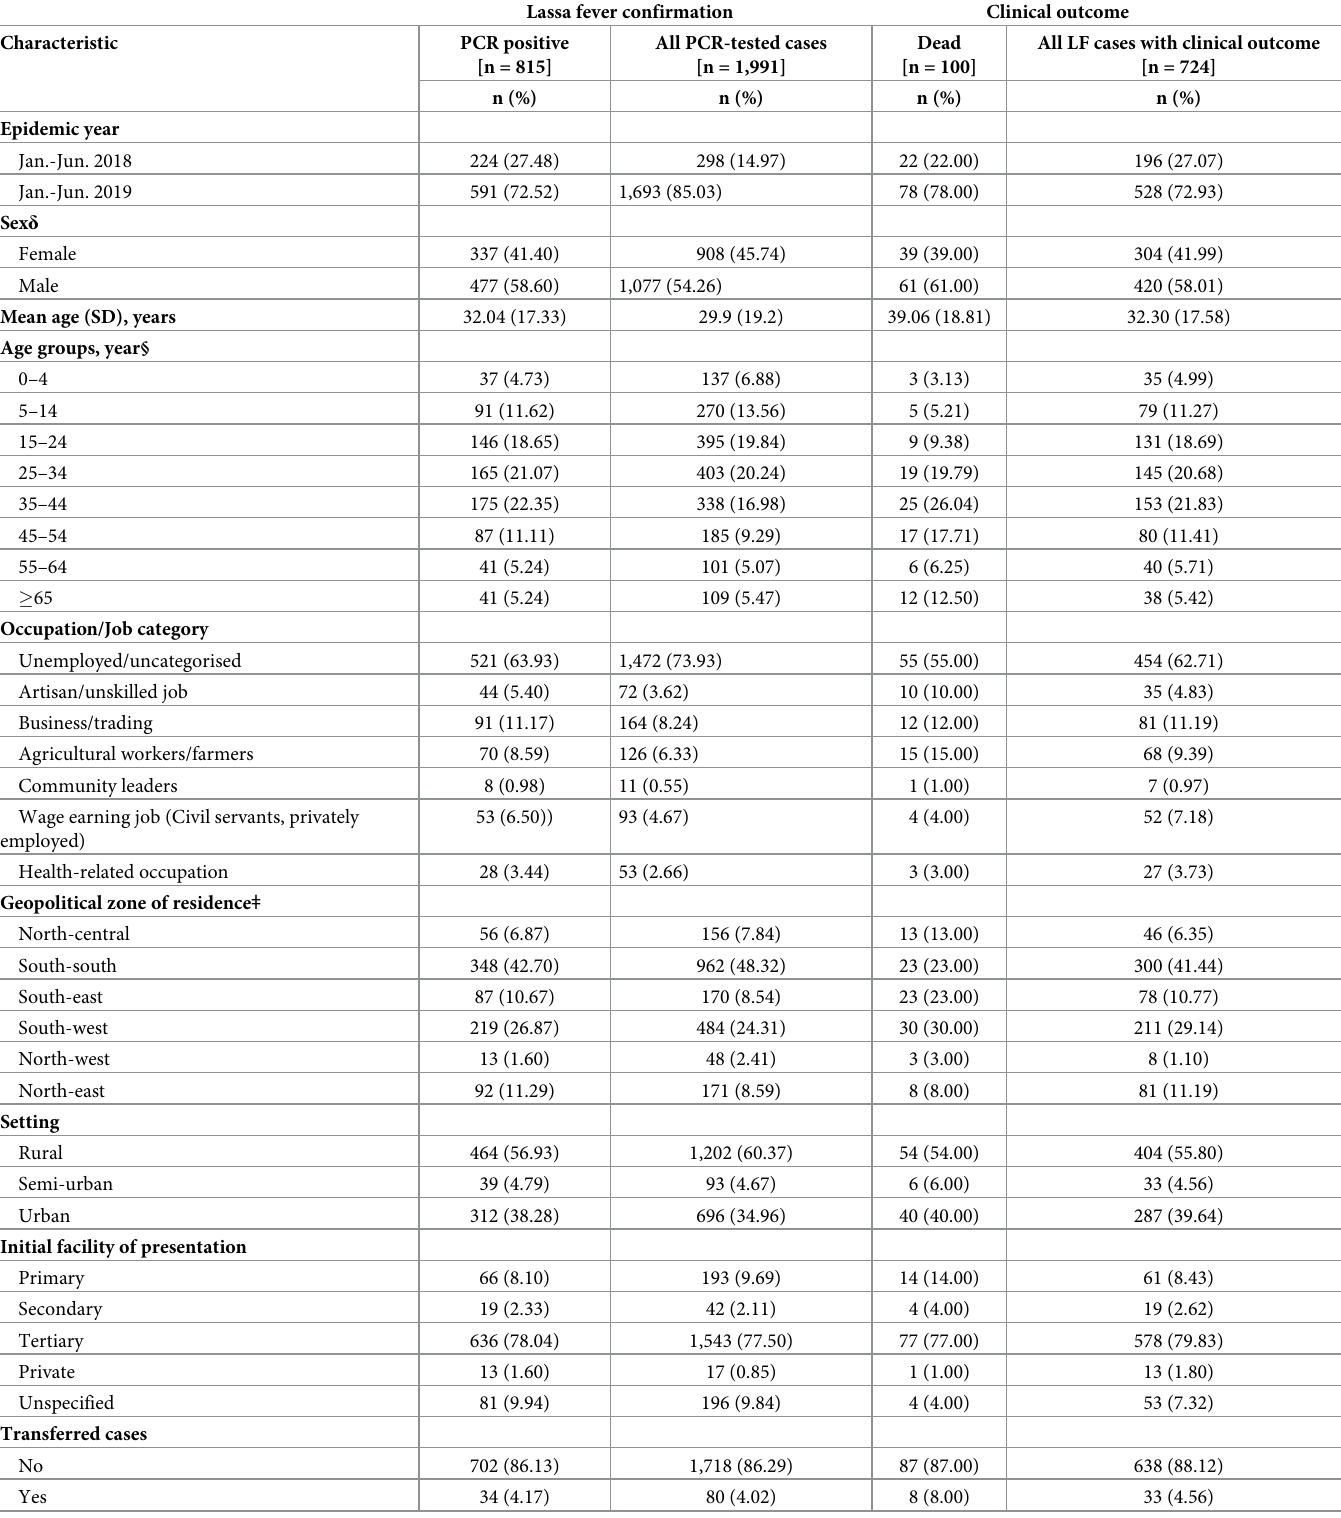
Table 2. Baseline characteristics of the study population in relation to Lassa fever confirmation and